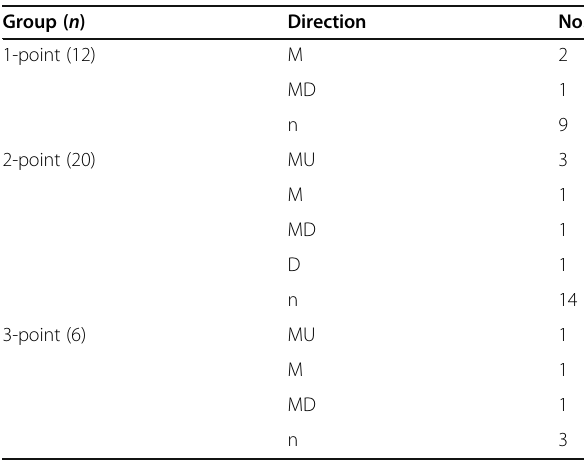
Table 3 The direction of postoperative relapse of the fractured